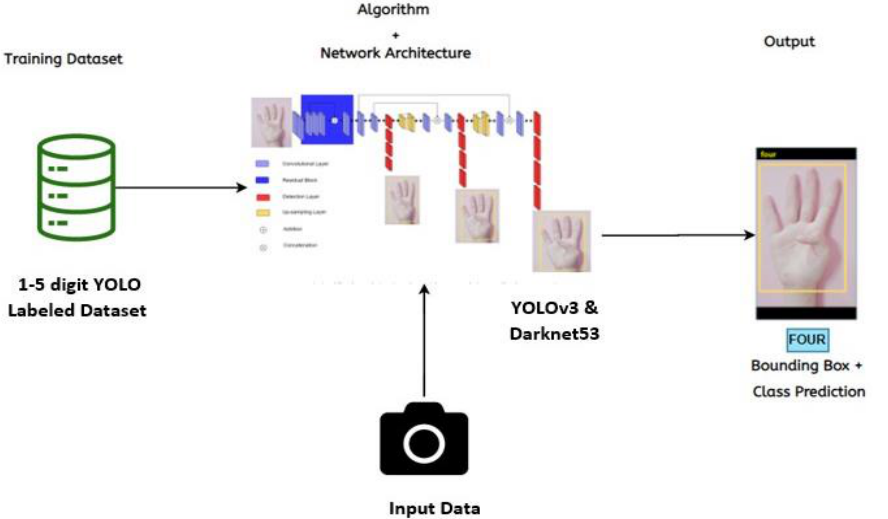
Figure 5. In-depth architectural flow of how the application deals with the recognition and detection of the input image with a gesture using YOLOv3 network.